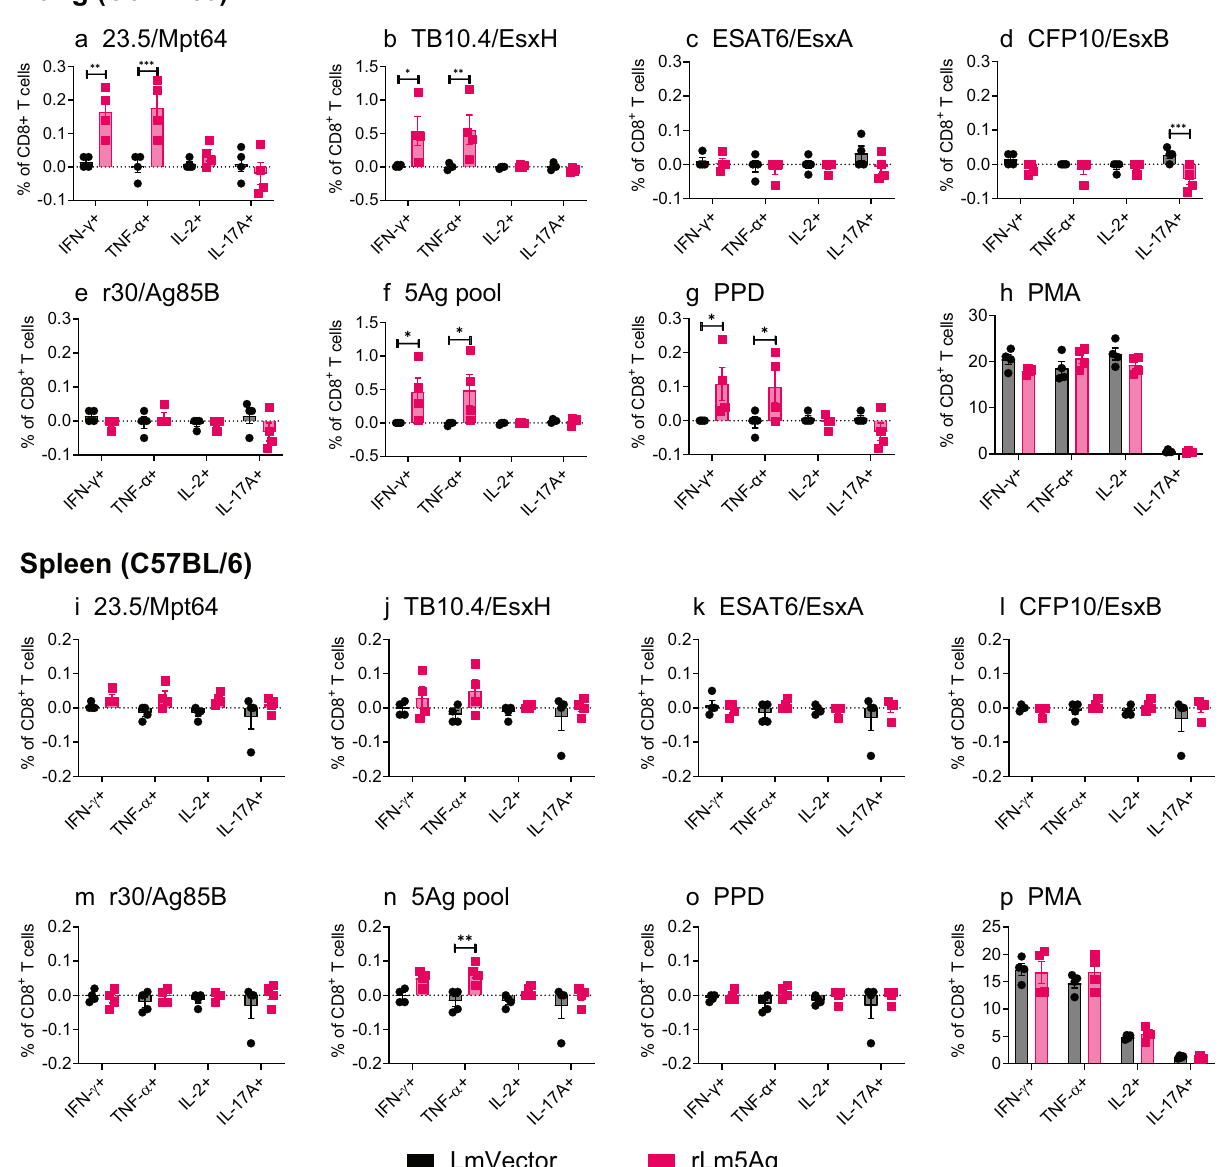
Fig. 4 Frequency of cytokine-expressing CD8 + T cells in the lungs and spleens of C57BL/6 mice immunized three times with LmVector or rLm5Ag. C57BL/6 mice ( n = 4/group, the same mice as shown in Fig. 2) were immunized three times s.q. with LmVector (black) or rLm5Ag (pink) at Weeks 0, 4, and 8. One week after the last immunization, animals were euthanized and their lung and spleen cells processed as described in the legend to Fig. 2. The lung and spleen cells were stimulated with individual proteins of 23.5/Mpt64 ( a , i ), TB10.4/EsxH ( b , j ), ESAT6/EsxA ( c , k ), CFP10/EsxB ( d , l ), or r30/ Ag85B ( e , m ), or pool of 5 antigens (5Ag pool) ( f , n ), PPD ( g , o ), or PMA ( h , p ), and assayed by intracellular cytokine staining for surface markers of CD4 and CD8 followed by CD3 and intracellular markers of IFN- γ , TNF- α , IL-2, and IL-17A. Frequencies of CD8 + T cells expressing any of the four cytokines are analyzed by FlowJo 10 software. Values are the mean ± SEM. * P < 0.05; ** P < 0.01; *** P < 0.001 by two-way ANOVA with Sidak ’ s post multiple comparisons ef fi cacy of the Lm vaccines, as BCG consistently provides strong respectively), not signi fi cantly different from mice immunized i.d. ef fi cacy in animal models of TB. We immunized groups of once with BCG (Fig. 6a, left middle and bottom panels); mice C57BL/6 mice, 8 per group, with PBS or BCG i.d. or i.n. at Week immunized i.n. once with BCG or three times with rLm5Ag * 0, or the rLm5Ag * i.d. or i.n. three times at Weeks 0, 7, and 10, showed no reduction in bacillus burden in the lungs compared challenged all the mice with aerosolized Mtb (average of 24 CFU with Sham-immunized mice (Fig. 6a, right middle panel), but had of the Mtb Erdman strain delivered to the lungs of each mouse, as signi fi cantly lower CFUs in their spleens than Sham-immunized assayed on Day 1 post-challenge) at Week 13 and euthanized the mice ( P < 0.0001 and P < 0.05, respectively) (Fig. 6a, right bottom mice at Week 23 (Fig. 6a, top panel). Mice immunized i.d. three panel). times with rLm5Ag * had signi fi cantly lower CFUs in their lungs Next, we immunized groups of 8 BALB/c mice with PBS and spleens than Sham-immunized mice ( P < 0.05 and P < 0.01, (Sham) or BCG (positive control) i.d. at Week 0, or i.m. with the